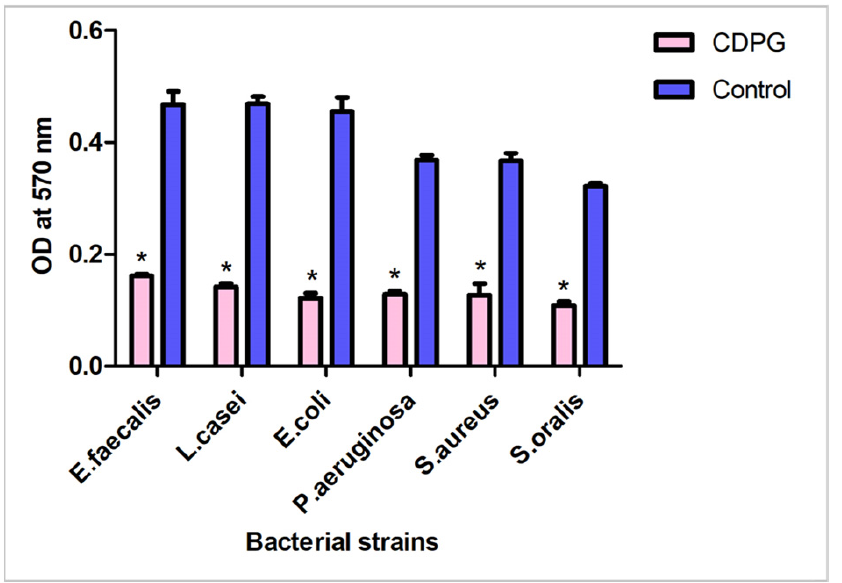
Figure 3. Crystal violet assay for evaluation of the antibiofilm activity of CDPG. * refers to the significant difference from the control with p value <0.05.